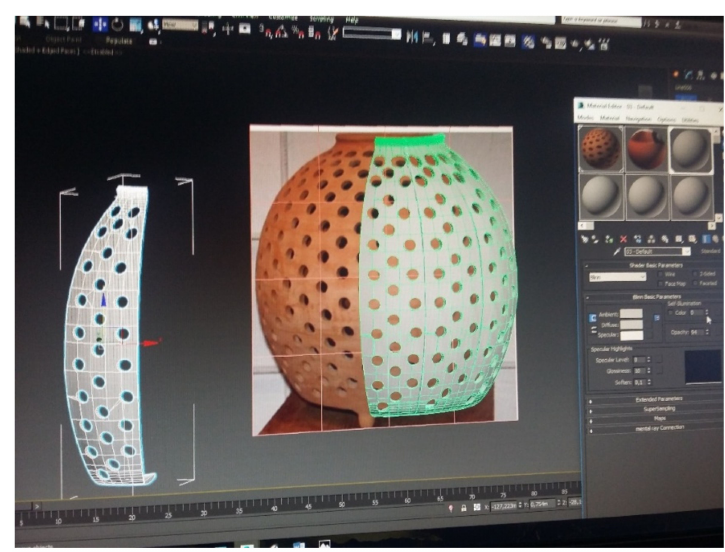
Figure 5. A snapshot of the process of creating a 3D model of a pottery jar with 3D Studio Max.